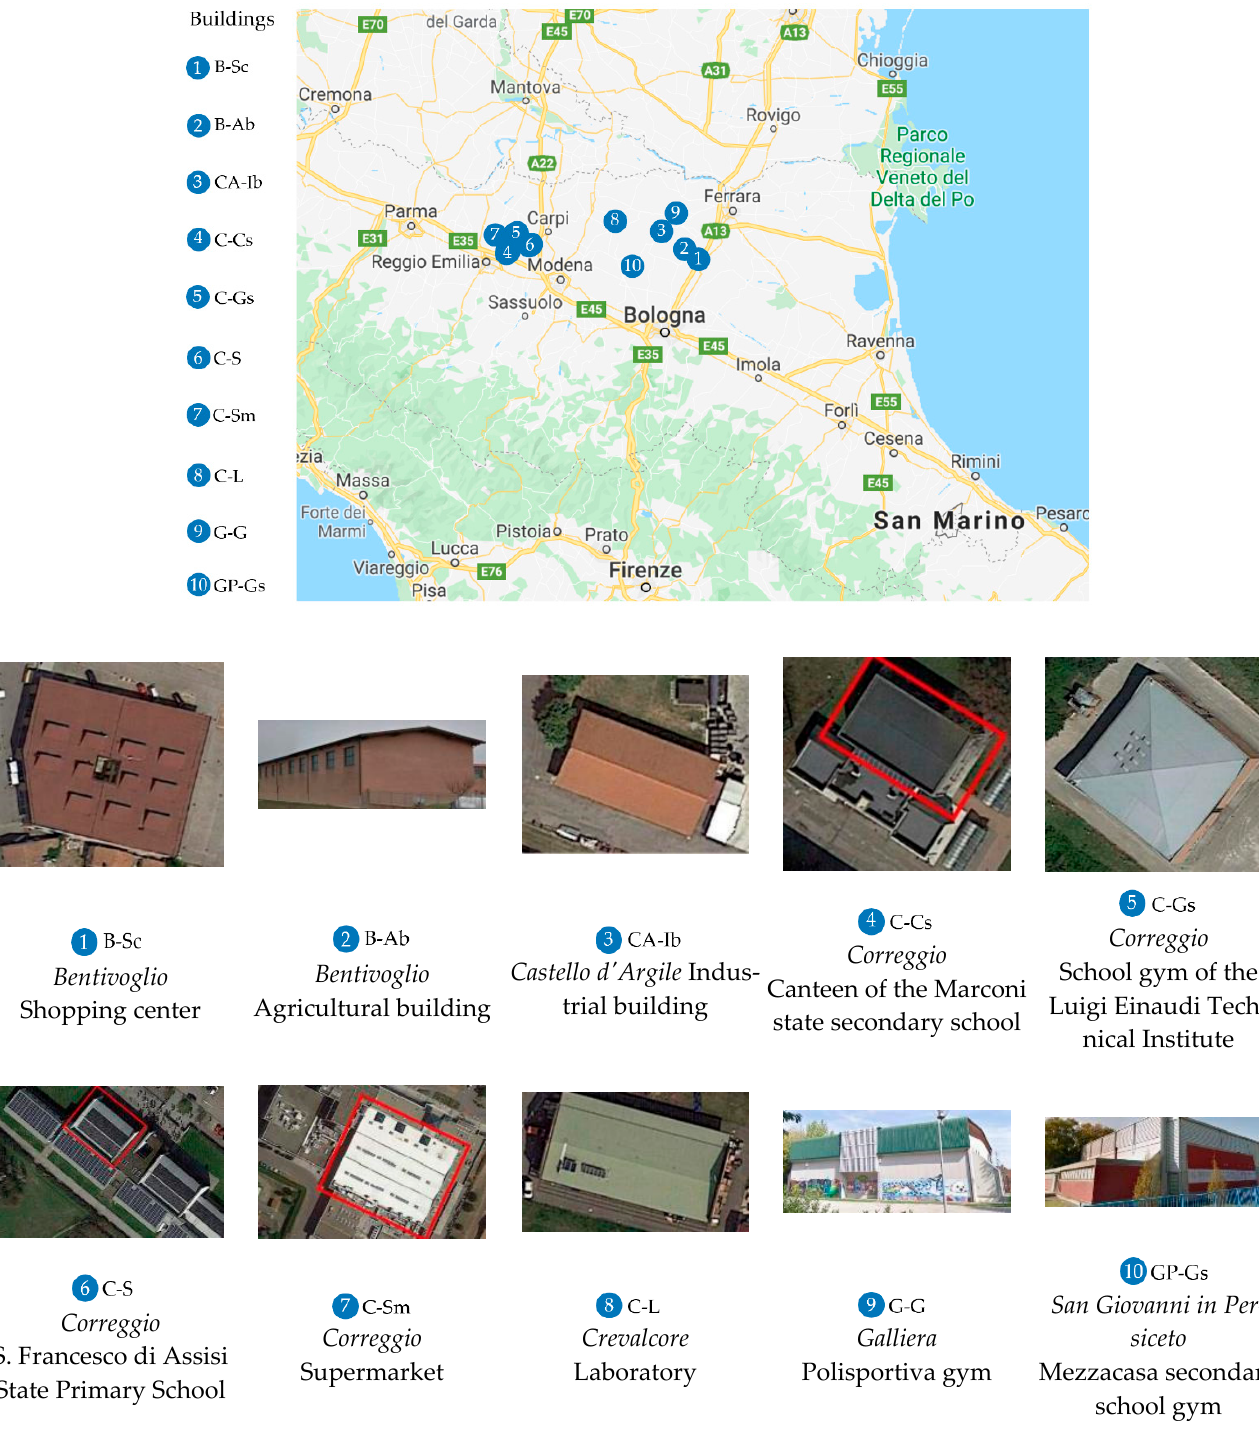
Figure 2. The sample of buildings.